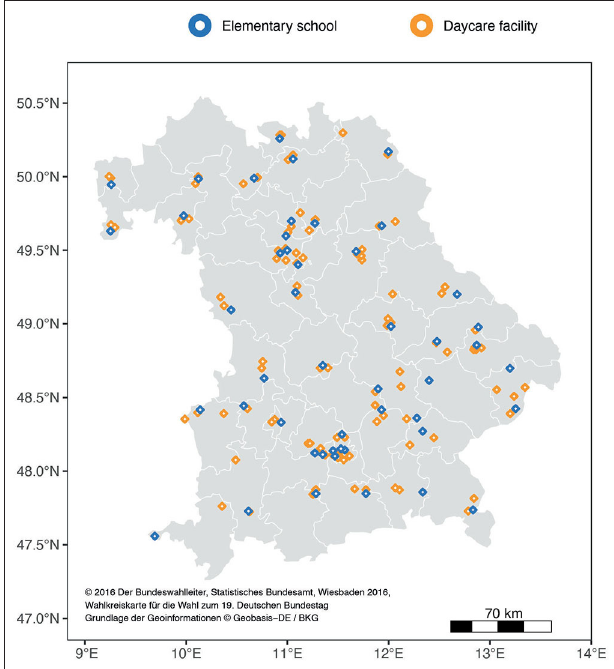
FIGURE 1 | Participating facilities in Bavaria: The white lines delineate the 46 electoral districts (Bundestag constituencies) with approximately equal population